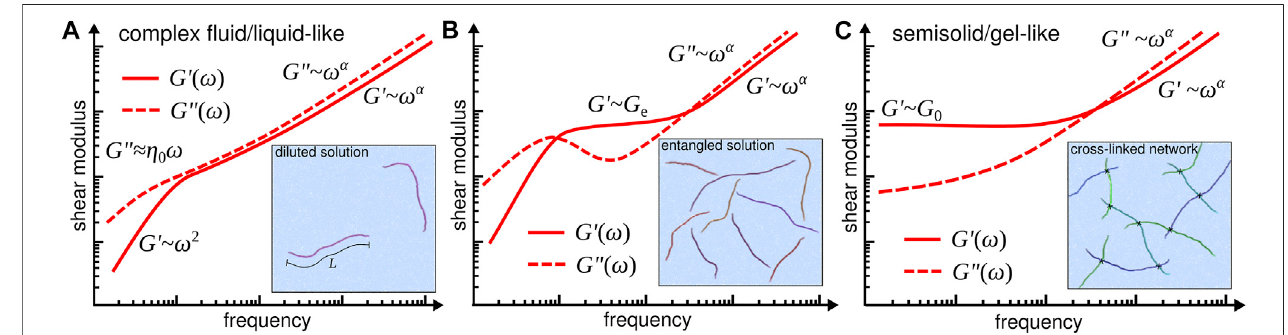
FIGURE1| Typicalviscoelasticresponsescharacterisedbytheshearmoduli G ′ ( ω )and G ′′ ( ω )for (A) complex fl uid/liquid-like, (B) entangled,and (C) semisolid/gel- likesolutionsofsemi fl exible fi laments.Insetdrawingsillustratethecon fi gurationsofthesemi fl exible fi lamentsandtheirinteractionsinsolution.Besidestheidenti fi cationof the distinct viscoelastic behaviours, the frequency-dependent shear moduli are often determined by experimentalists to provide a lower bound for the stiffness of the polymer biomaterials at different time scales [12].